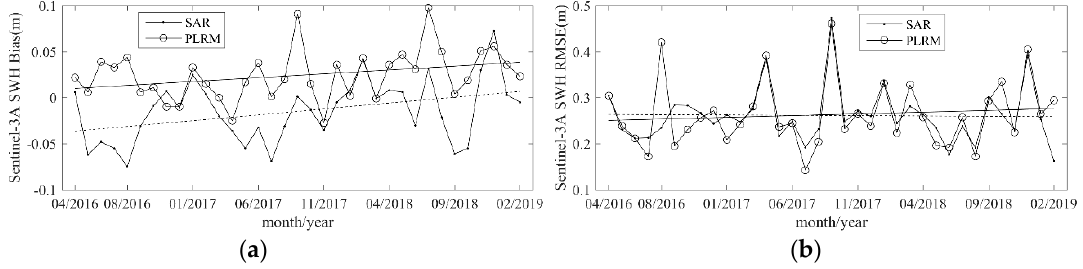
Figure 14. ( a ) Monthly bias and ( b ) RMSE of Sentinel-3A SWH across different months from February 2017 to January 2019; the solid and dotted straight lines are the fitting trends.